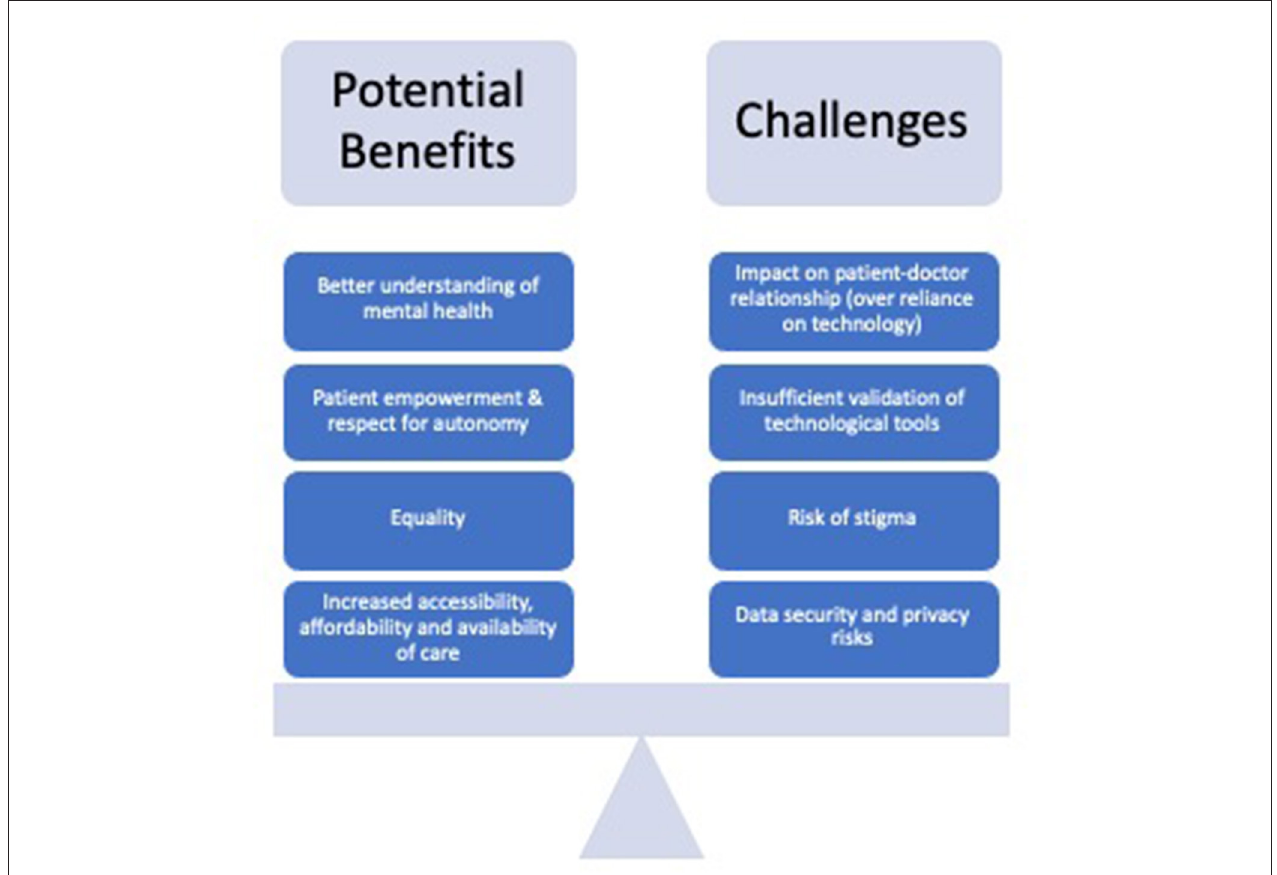
FIGURE 2 | Expected benefits and ethical challenges related to digital mental health for young